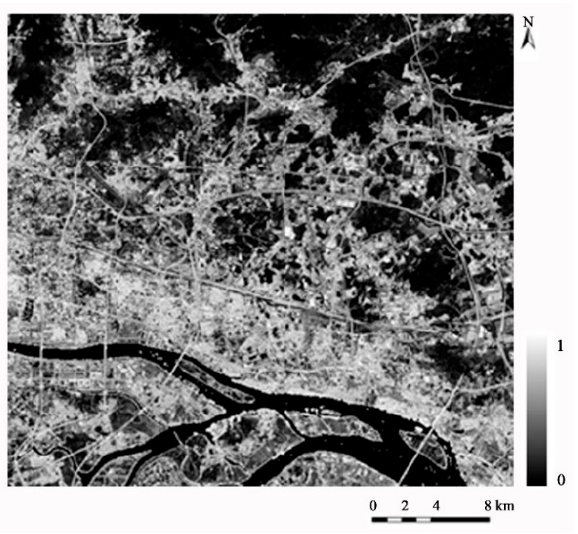
Figure 6. Abundance of the impervious surfaces.